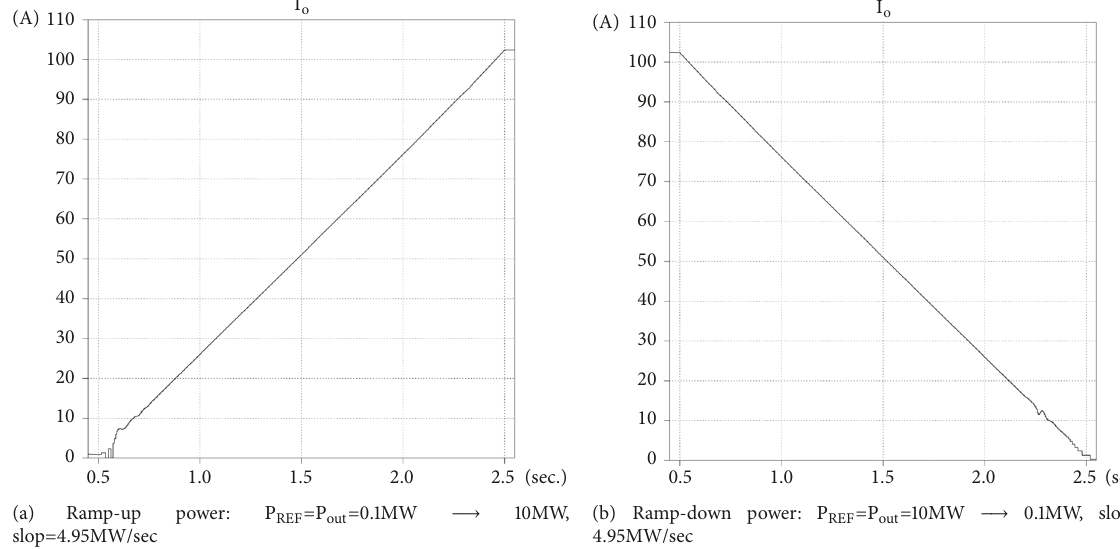
Figure 14: Output current (I ) of the series resonant converter with a ramp-power reference P o controller and demonstrate the start-up process of DC wind converter.